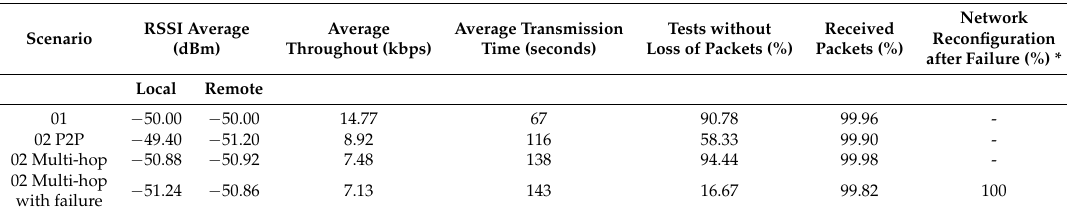
Table 12. Results of data transmission tests. * Network reconfiguration test performed only in scenario 2 in the third case (02 Multi-hop with